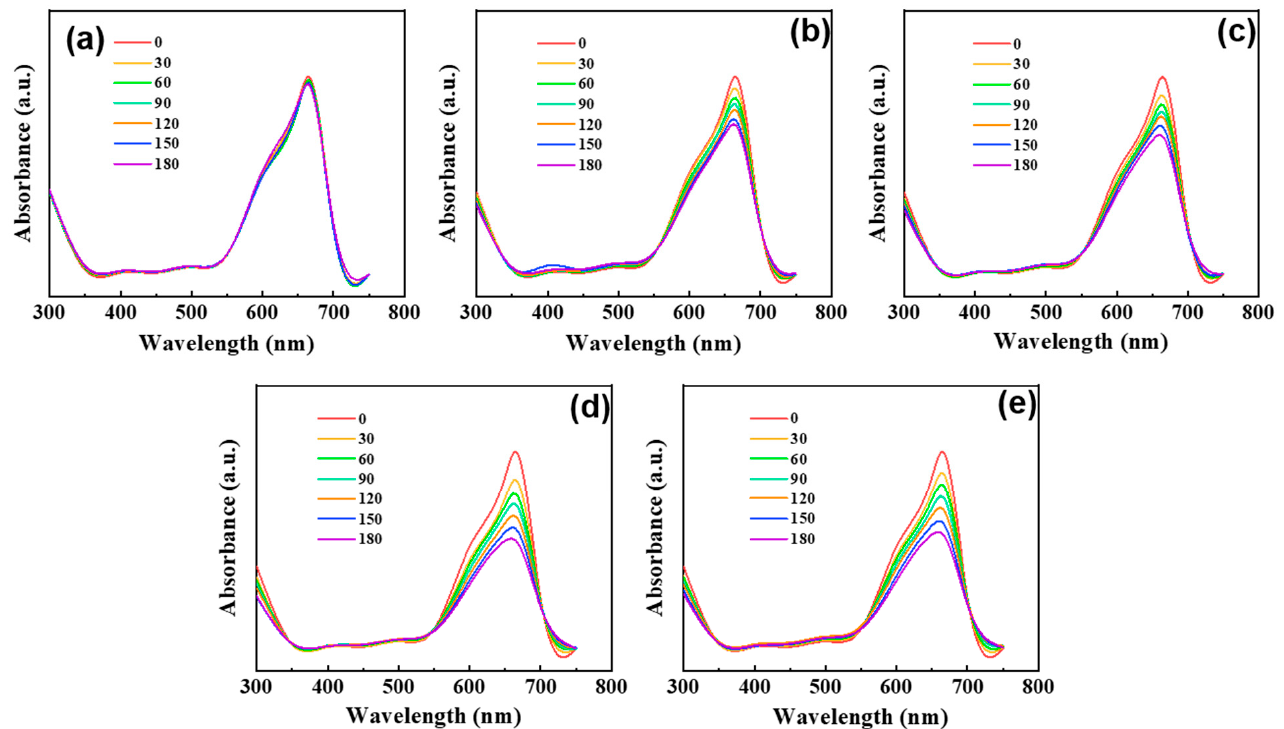
Figure 4. Absorption spectral pattern of ( a ) control and ( b – e ) MB during photocatalytic degradation process in the presence of LC-ZnO/OF under visible light irradiation.